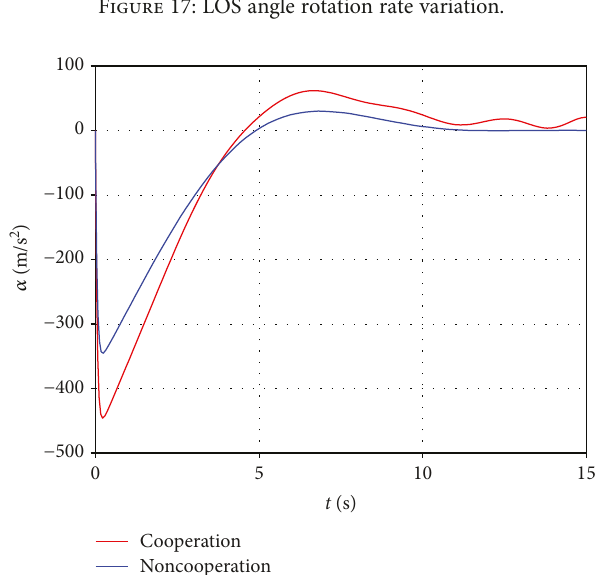
Figure 17: LOS angle rotation rate variation.